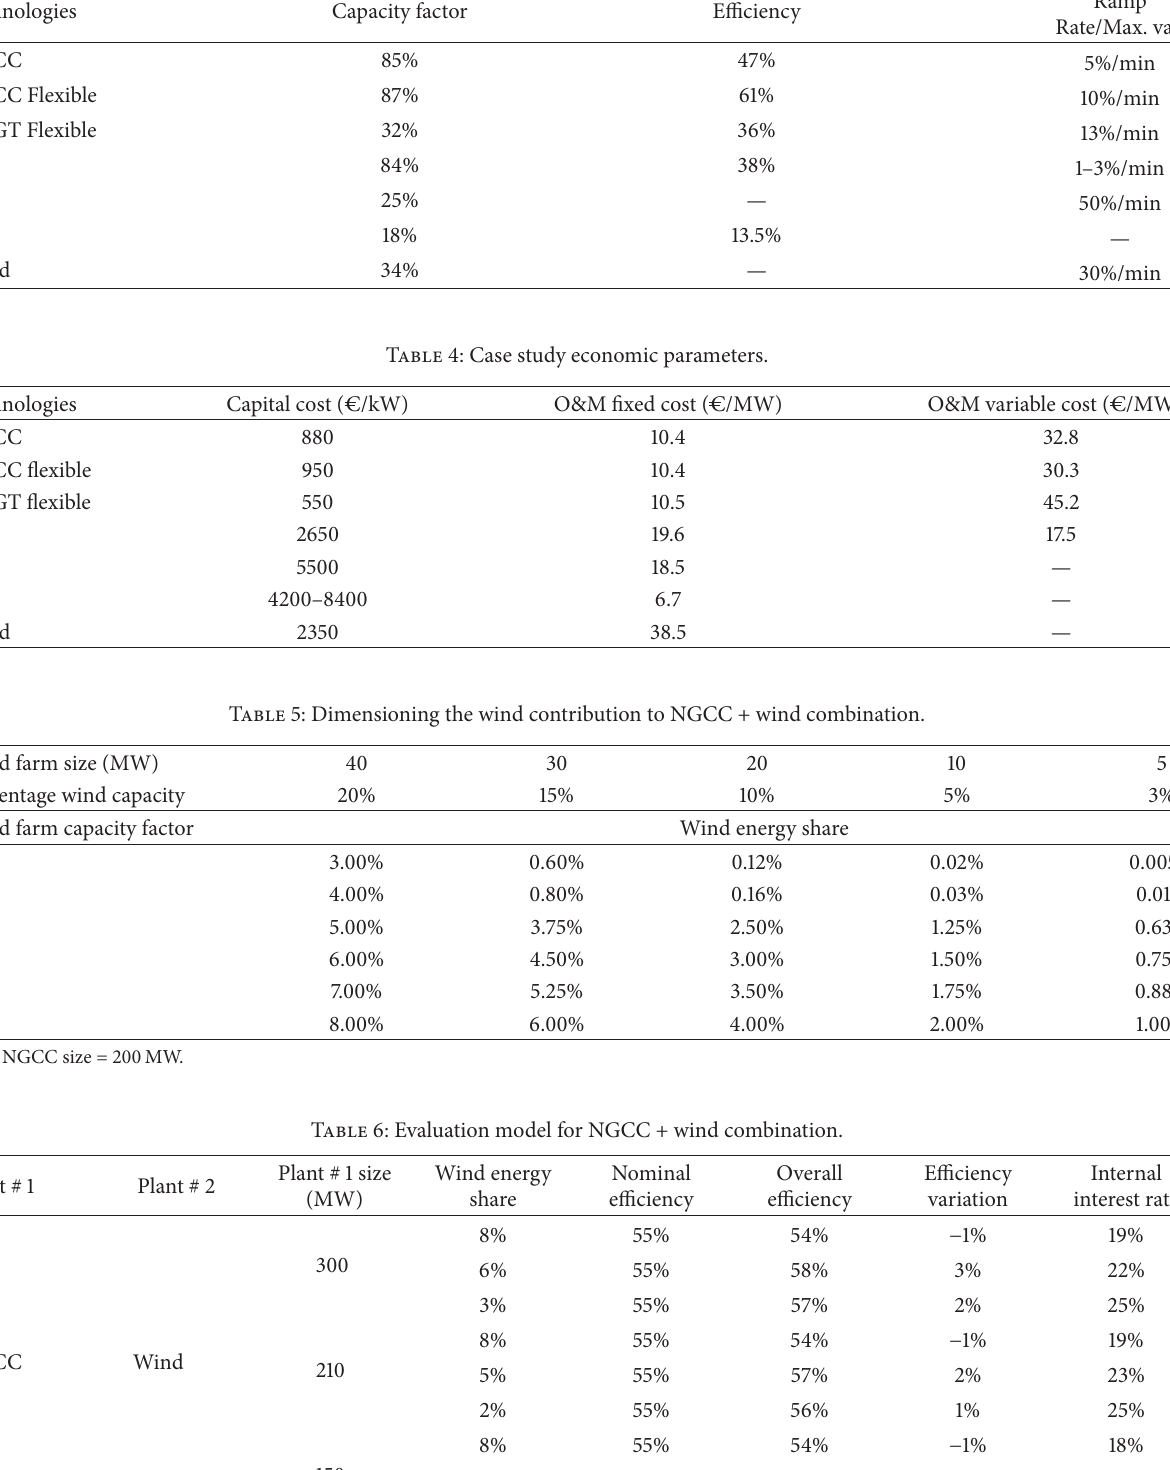
Table 3: Case study technical parameters.